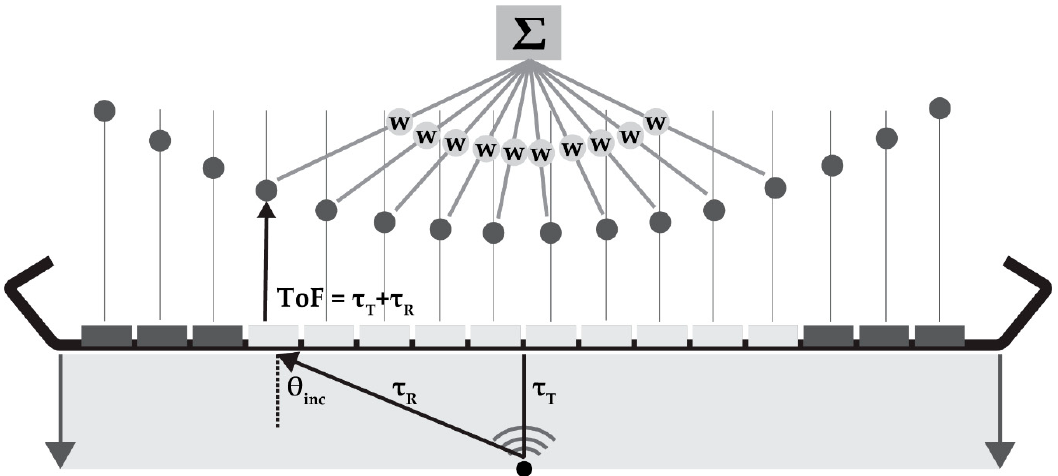
Figure 2. Schematic overview of delay-and-sum (DaS) beam-forming: for each reconstruction point, the time-of-flight (ToF) can be calculated by the transmit ( τ T ) and receive time towards each element ( τ R ). These ToF values are used to delay and sum the element data; if required the data can be weighted (w) by an apodization function. θ inc is the incidence angle of the signal.